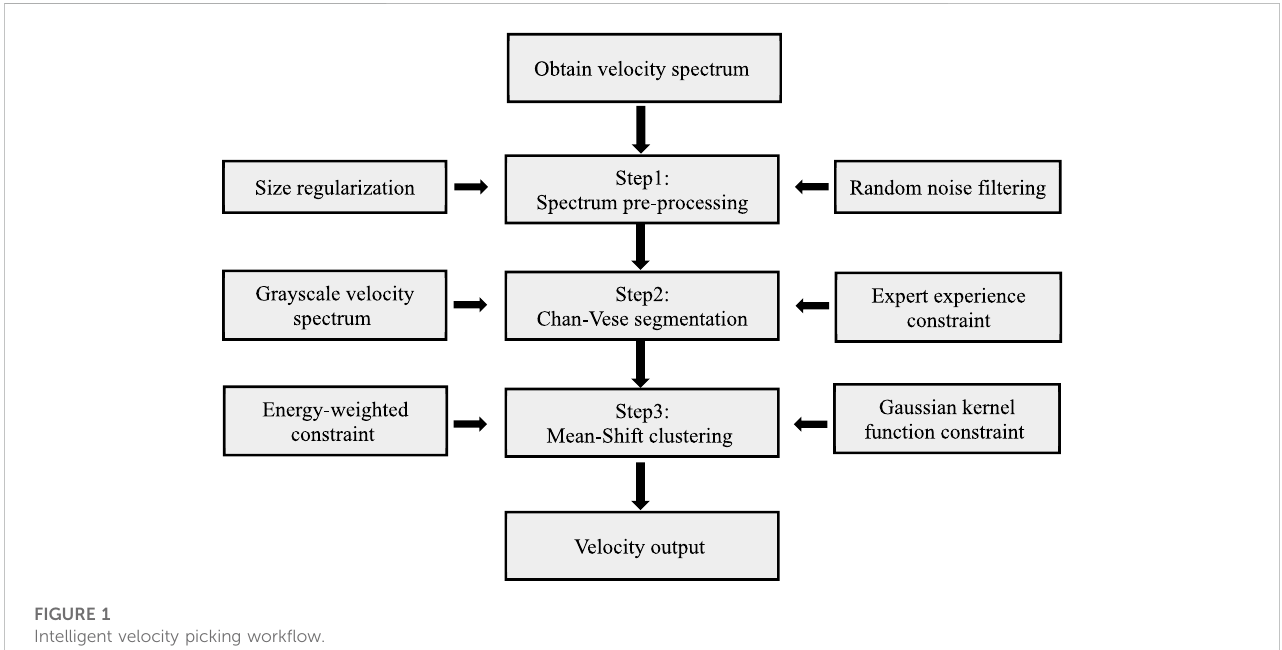
FIGURE 1 Intelligent velocity picking work fl